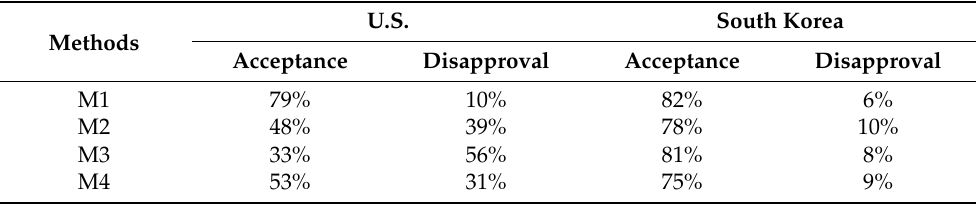
Table 5. Acceptance and disapproval rates for the four contact tracing